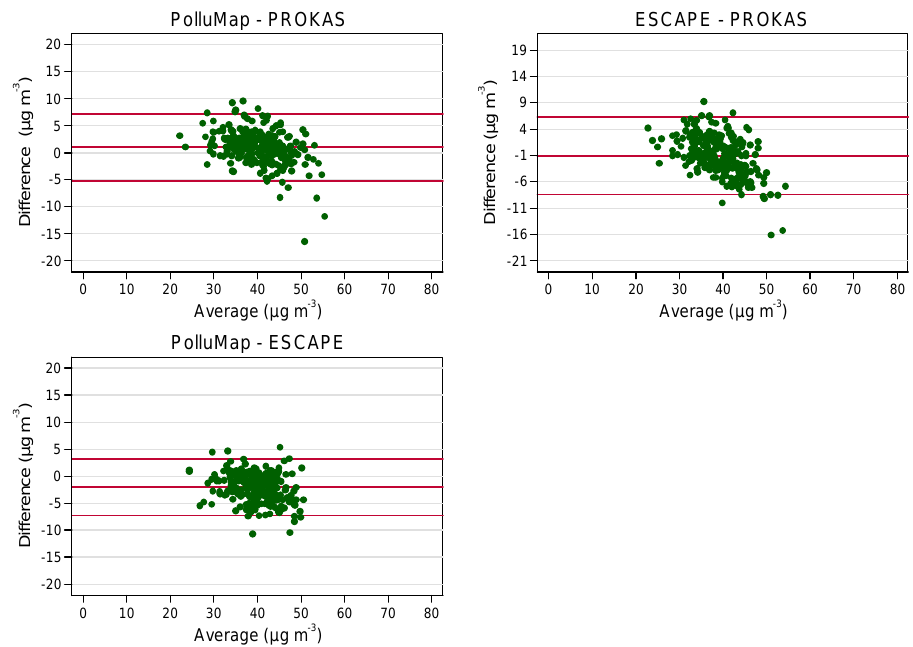
Figure 4. Bland Altman plots of time-weighted commuter NO commuting within Basel-City ( n = 258). The lines represent the mean difference ±2 × standard